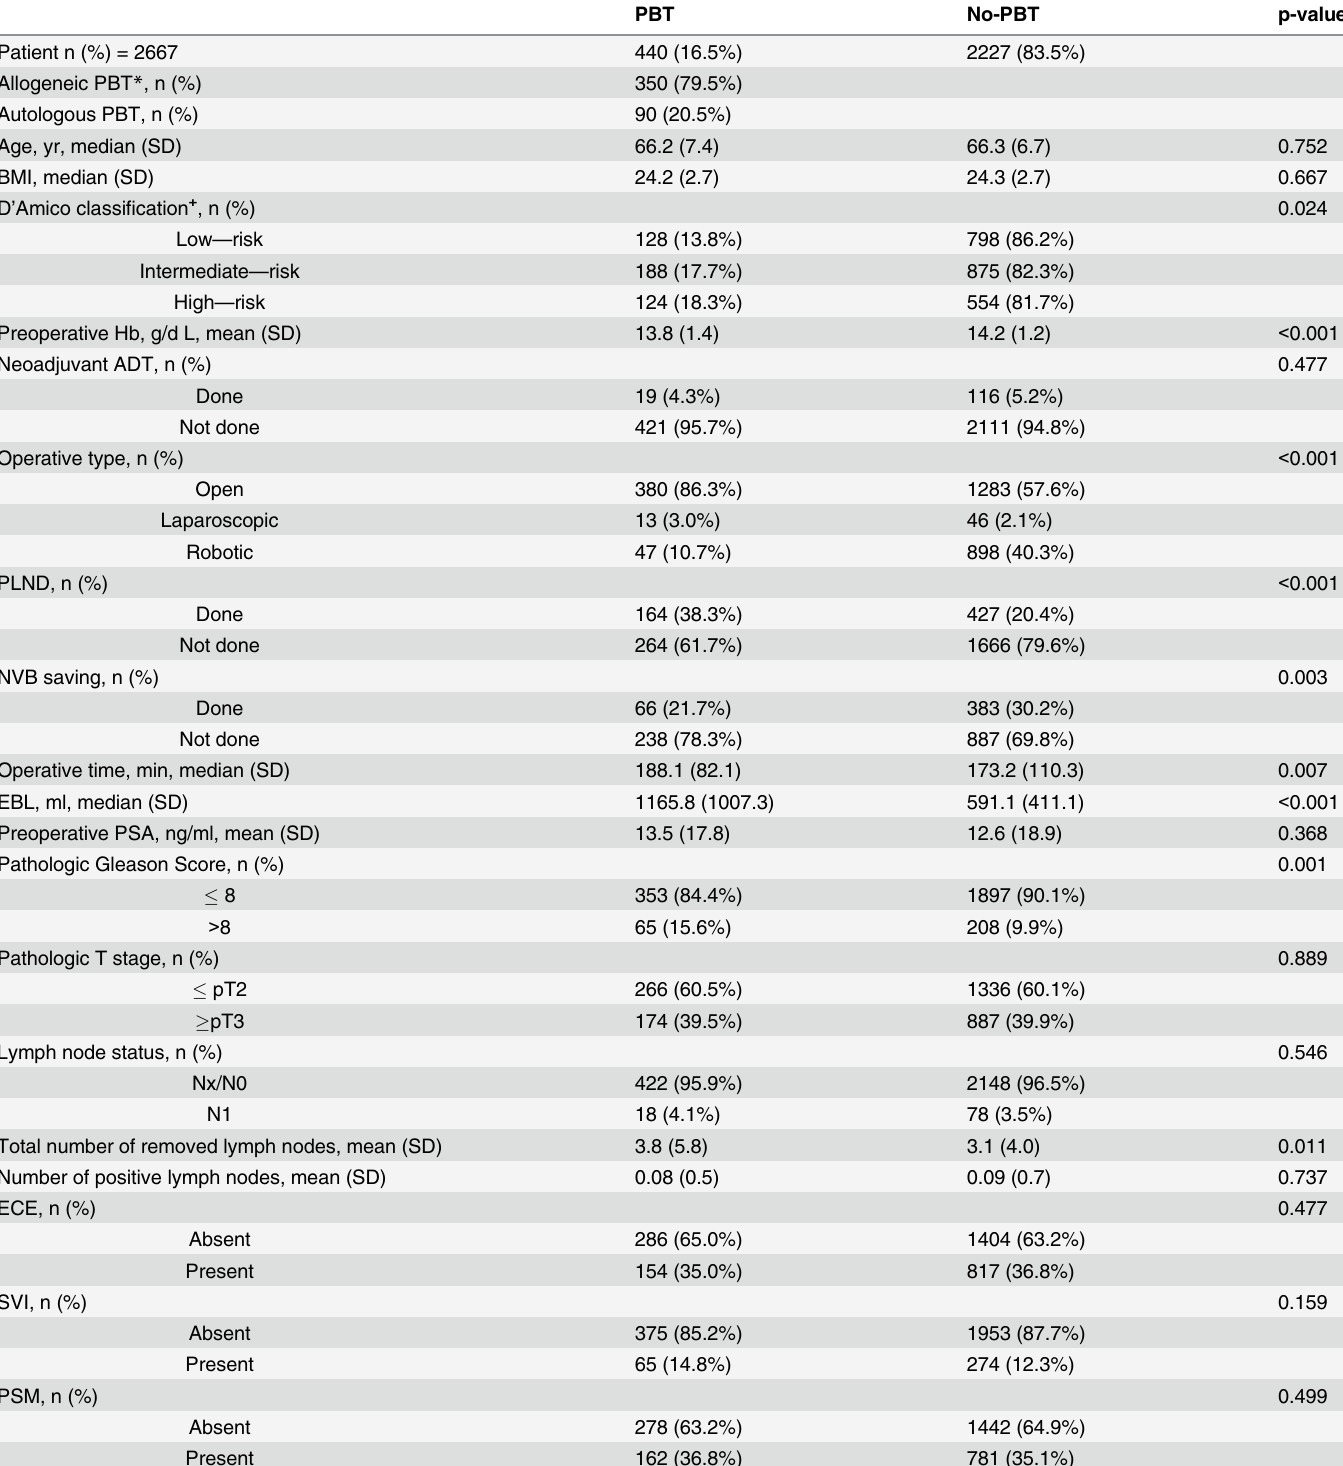
Table 1. Clinicopathological parameters of the comparative analysis results according to the presence or absence of perioperative blood transfu- sion